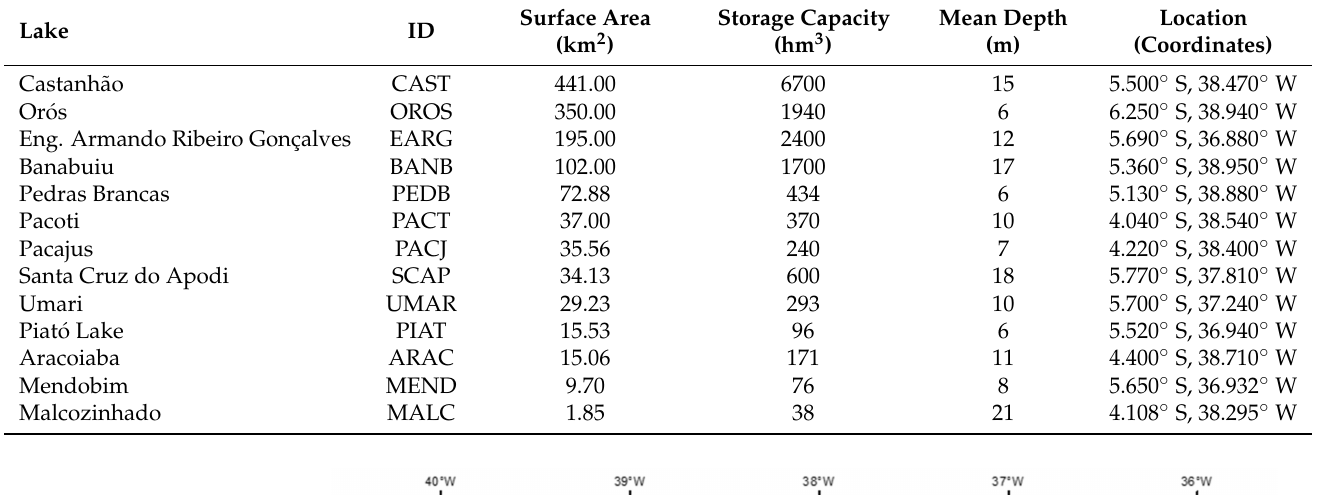
Table 1. Study lakes in the Brazilian semiarid region.